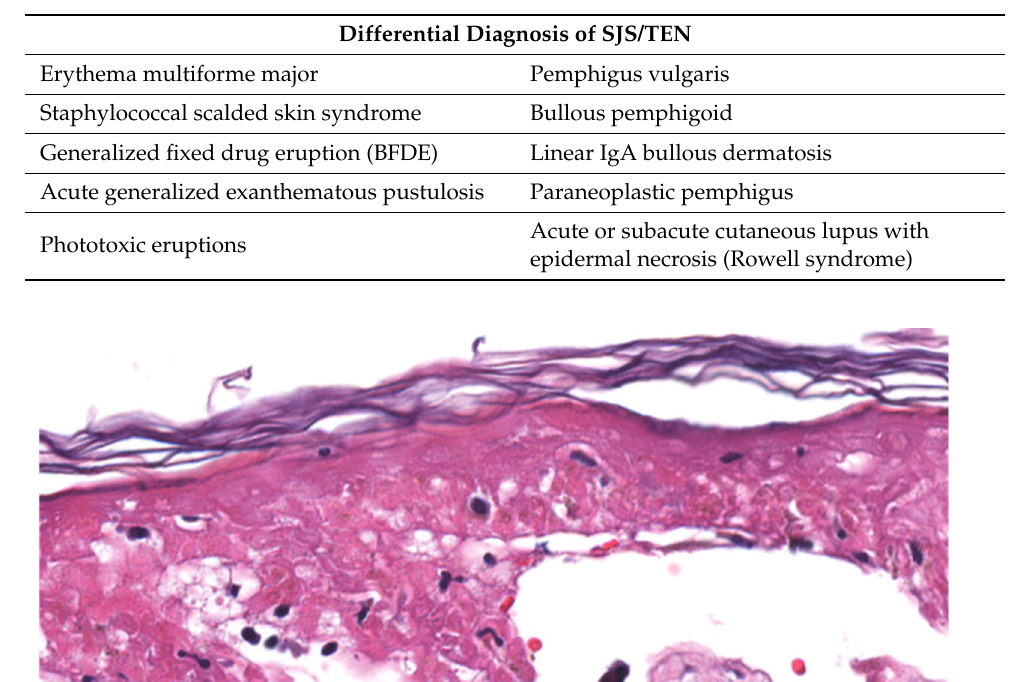
Table 3. Differential diagnosis of suspected SJS/TEN.